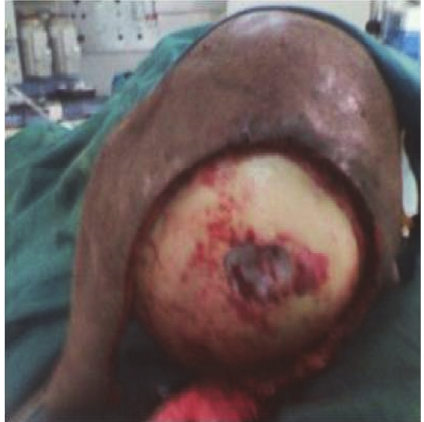
Figure 3: Temporoparietal fascial flap raised on the superficial temporal vessels.